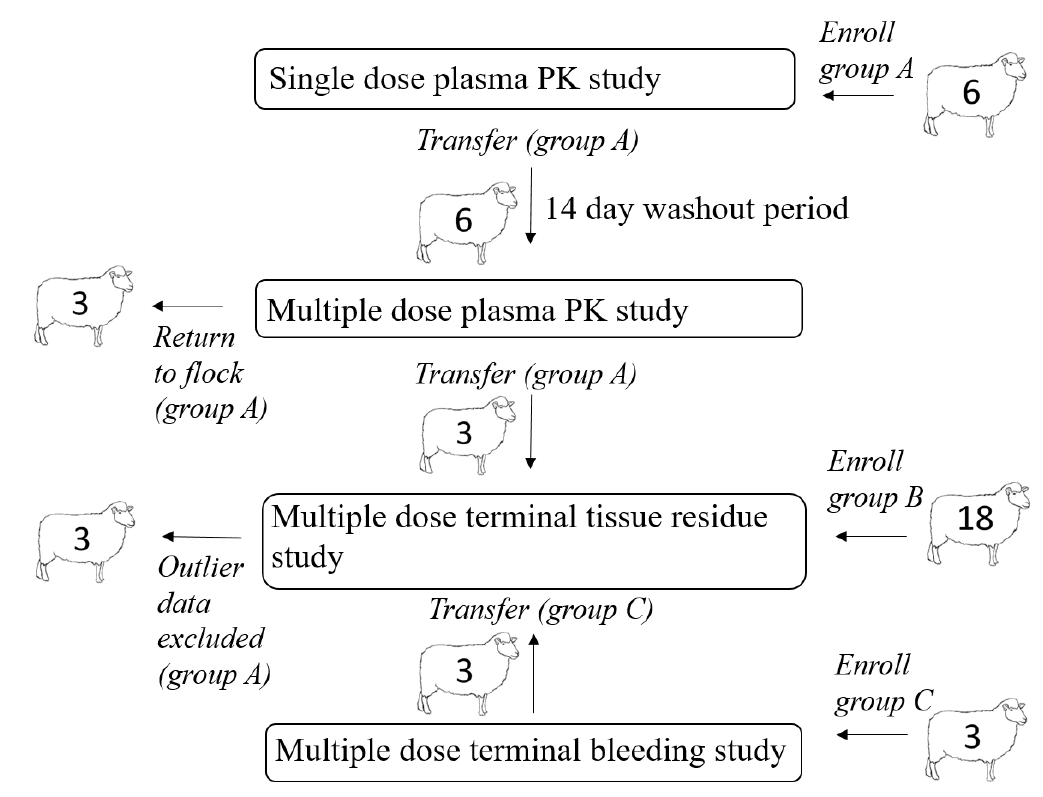
Figure 1. Relationship between animal use in each portion of the study. Numerals indicate animal numbers. A total of six sheep were included in the single dose live animal plasma PK study (group A); after the washout period these sheep were included in the multiple dose live animal plasma PK study. Three sheep from the multiple dose live animal PK study were slaughtered at the 192-h time point and samples were harvested for the tissue residue study. These animals were ultimately excluded from the data analysis. An additional 18 sheep (group B) were enrolled in the tissue residue depletion study. An additional 3 sheep (group C) were enrolled in a multiple dose terminal bleeding study; these sheep (group C) were included in terminal tissue residue study at slaughter.